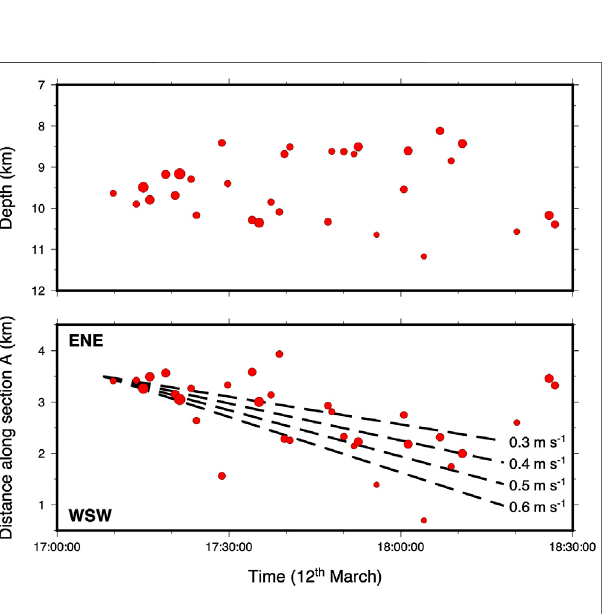
Frontiers in Earth Science |